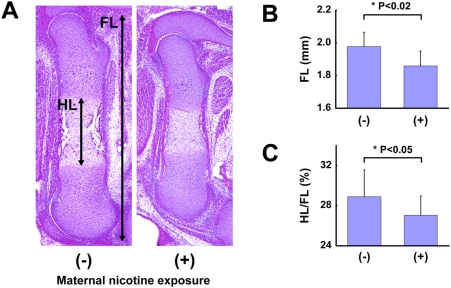
Maternal nicotine exposure in wild-type mice.Ovulation-induced pregnant mice were mated and were given drinking water with nicotine during pregnancy. At noon on gestational day 15, the fetuses were sacrificed, and their legs were histologically investigated. A: Skeletal growth estimated by measuring the femur length (FL) and the length of the hypertrophic zone of the femur (HL). B: FL (mm), C: HL/FL (%) of E15.5 fetuses whose mothers were given drinking water with or without nicotine. Nicotine significantly decreased FL and HL/FL.